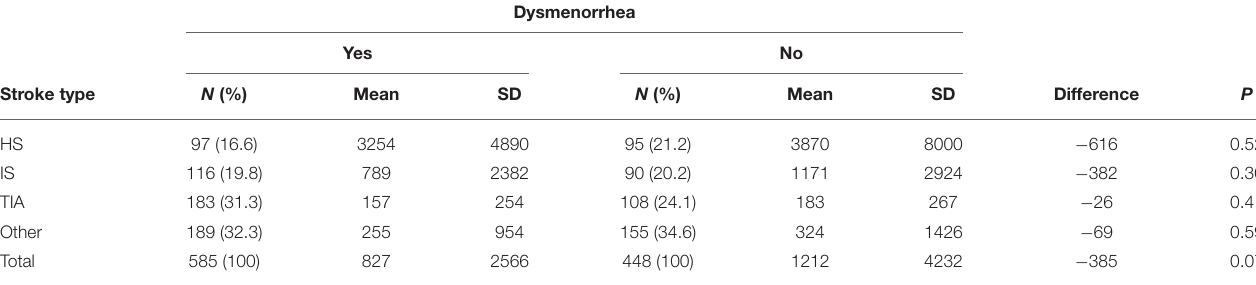
TABLE 4 | Comparison of the average cost of stroke care (USD) between women with and without dysmenorrhea by stroke